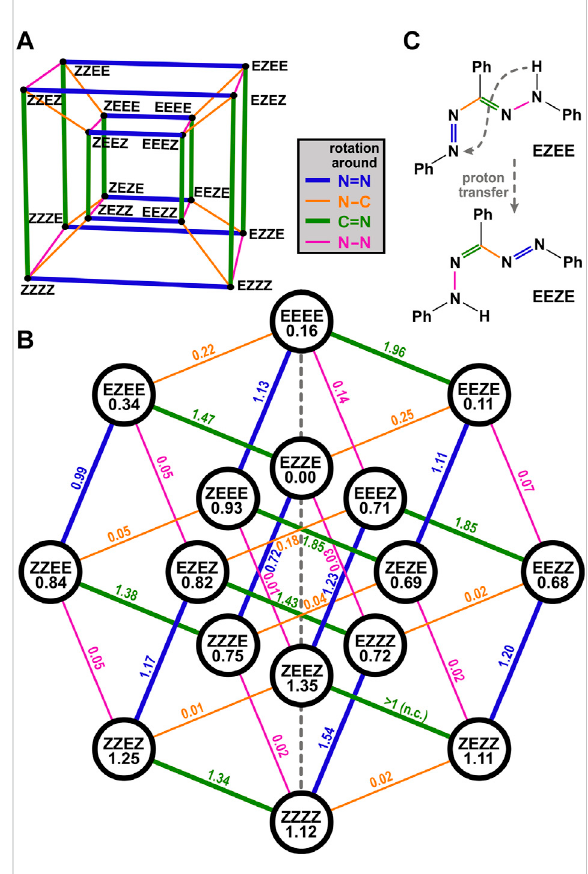
FIGURE 7 Reaction pathways illustrated as Schlegel diagram (A) or hypercubegraph (B) .Theisomers ’ calculatedenergies,referenced to the energetically most stable geometry EZZE, are written in the circles, barrier heights are shown above the reaction pathway; all values are in eV. The fi nal single point energies of the individual isomers were optimized by DFT calculations on the B3LYP/def2-TZVP level of theory. The energy barriers between two adjacent isomeric species of TPF are roughly estimated by relaxed surface scans along a fi xed torsional angle. The stated values along the possible pathways always describe the amount of energy to overcome the energy barrier from the energetically higher lying isomer to the energetically more favored species. The performed calculations are summarized in Supplementary Figure S8. Note that in case of one barrier height the calculation did not converge (n.c.). (C) exemplarilydisplaysthat